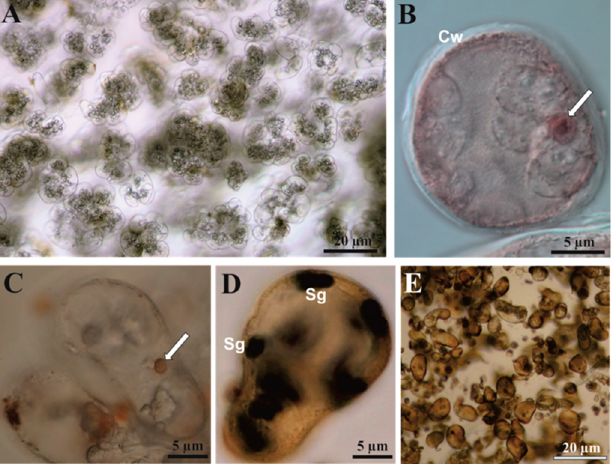
Figure 1. Callus induction and establishment of the cell suspension culture. ( A ) General view of root system of four-month-old axenic culture in jar. ( B ) Callus proliferation of root explant in the pres- ence of 0.5 MS medium supplemented with 9.05 µM 2,4-D + 0.88 µM BAP and 2% sucrose after 6 weeks of culture. ( C ) Semi-thin section of callus showing small groups of cells containing nuclei in interphase, starch grains, and electron-dense bodies. Sections stained with toluidine blue (arrow). ( D ) General view of the conical flask containing the established cell suspension with yellow colora- tion of the medium. Cp—callus proliferation center; Eb—electron-dense body; N—nucleus; Rs— root system; Sg—starch grains.